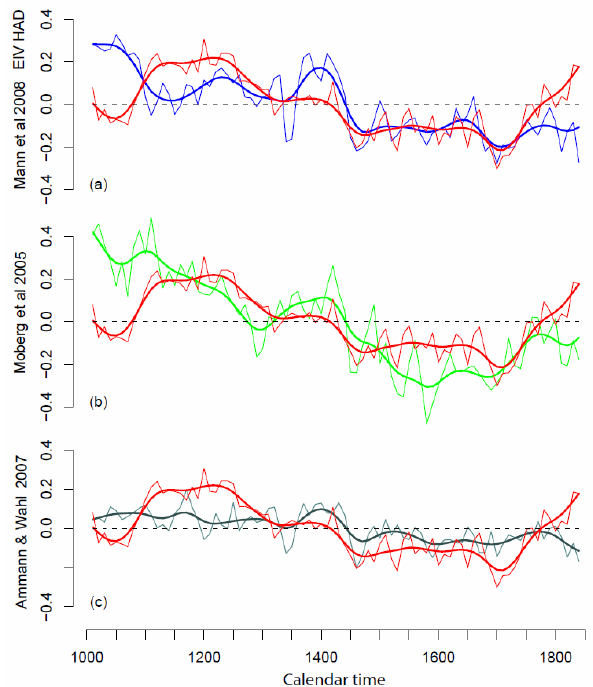
Fig. 1. (a) Radiative forcing on the Northern Hemisphere of the Total Solar Irradiance (TSI) reconstruction from Crowley (2000) (black line), CO 2 (blue line) and orbital forcing (dashed line). The total anthropogenic forcing (orange line) is the radiative forcing of all the well-mixed greenhouse gases estimated by (Dufresne et al., 2005) and the radiative forcing of the tropospheric aerosols recon- structed by (Boucher and Pham, 2002), minus the radiative forcing of the CO 2 (blue line). On the right are represented the axis giving the values of TSI at the top of the atmosphere and CO 2 concentra- tions implemented in the model. The anomalies are calculated rel- ative to the 1500–1899 AD reference period. (b) Radiative forcing of the downward short wave flux at the top of the atmosphere in the model at 65 ◦ N (grey line) modulated by both TSI variations and orbital parameters (Laskar et al., 2004) and changes in insolation alone (black line). The values are represented on anomalies relative to the 1000–2000 AD period. (c) Northern Hemisphere tempera- ture anomalies relative to the 1500–1899 AD reference period. The thick red line represents the SGI simulation forced by TSI, GHGs, anthropogenic aerosols and orbital forcing described in panel (a), and the dashed red line shows the complementary run VHIST on the industrial period with the volcanic forcing (not shown) used in the ENSEMBLE project (Royer et al., 2009). The shaded area cor- responds to the reconstructions overlap performed by Osborn and Briffa (Jansen et al., 2007). The thin black lines depict the upper and lower boundaries of a set of numerical simulations taken from the IPCC AR4 and (Swingedouw et al., 2010), achieved with sim- ilar solar and GHGs forcing. The thin green line shows the NH temperature of the preindustrial control run (CTRL), and the thick dark green line shows the low frequency NH temperature trend es- timated with a cubic spline function in CTRL. This trend has been removed from the SGI and CTRL NH temperature time series rep- resented in this figure. All the series have been smoothed with a 10-yr running mean.